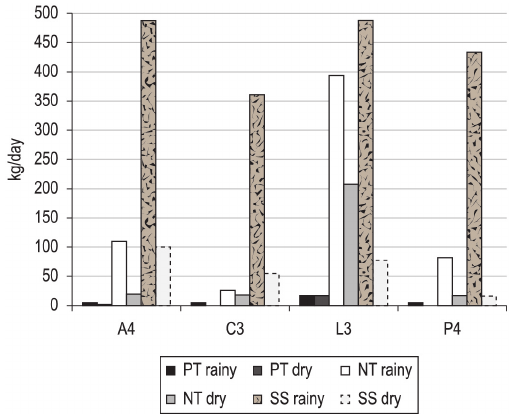
Figure 6. PT, NT and SS loads in Araquá (A4), Capivara (C3), Lavapés (L3) and Pardo (P4)